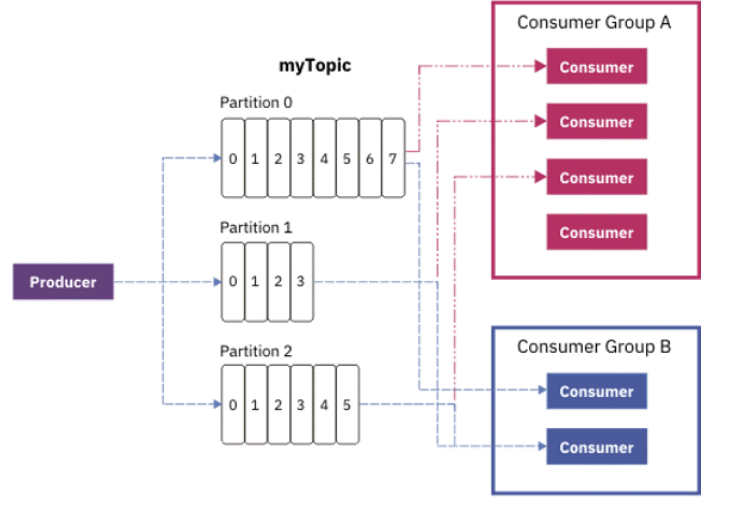
Figure 1. Kafka uses a fault-tolerant, low-latency publish-subscribe messaging